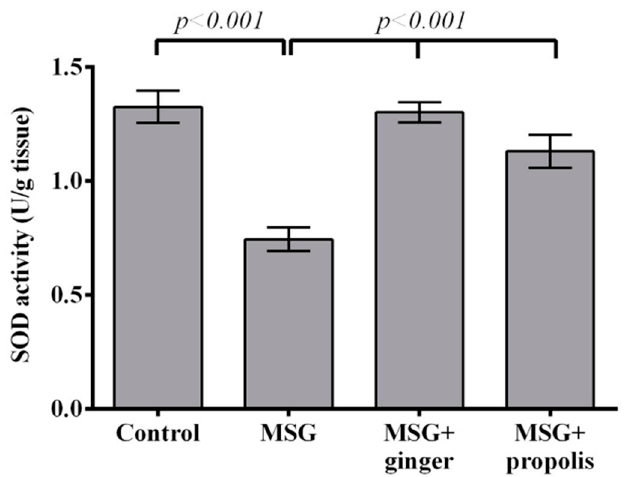
Figure 8. Effects of aqueous extract of ginger and propolis on SOD enzyme activity in the brain tissue of experimental groups. Data are expressed as mean ± SEM ( n = 6). Comparisons were made between normal control and MSG control groups, and also between MSG control and MSG plus ginger or propolis supplement groups.